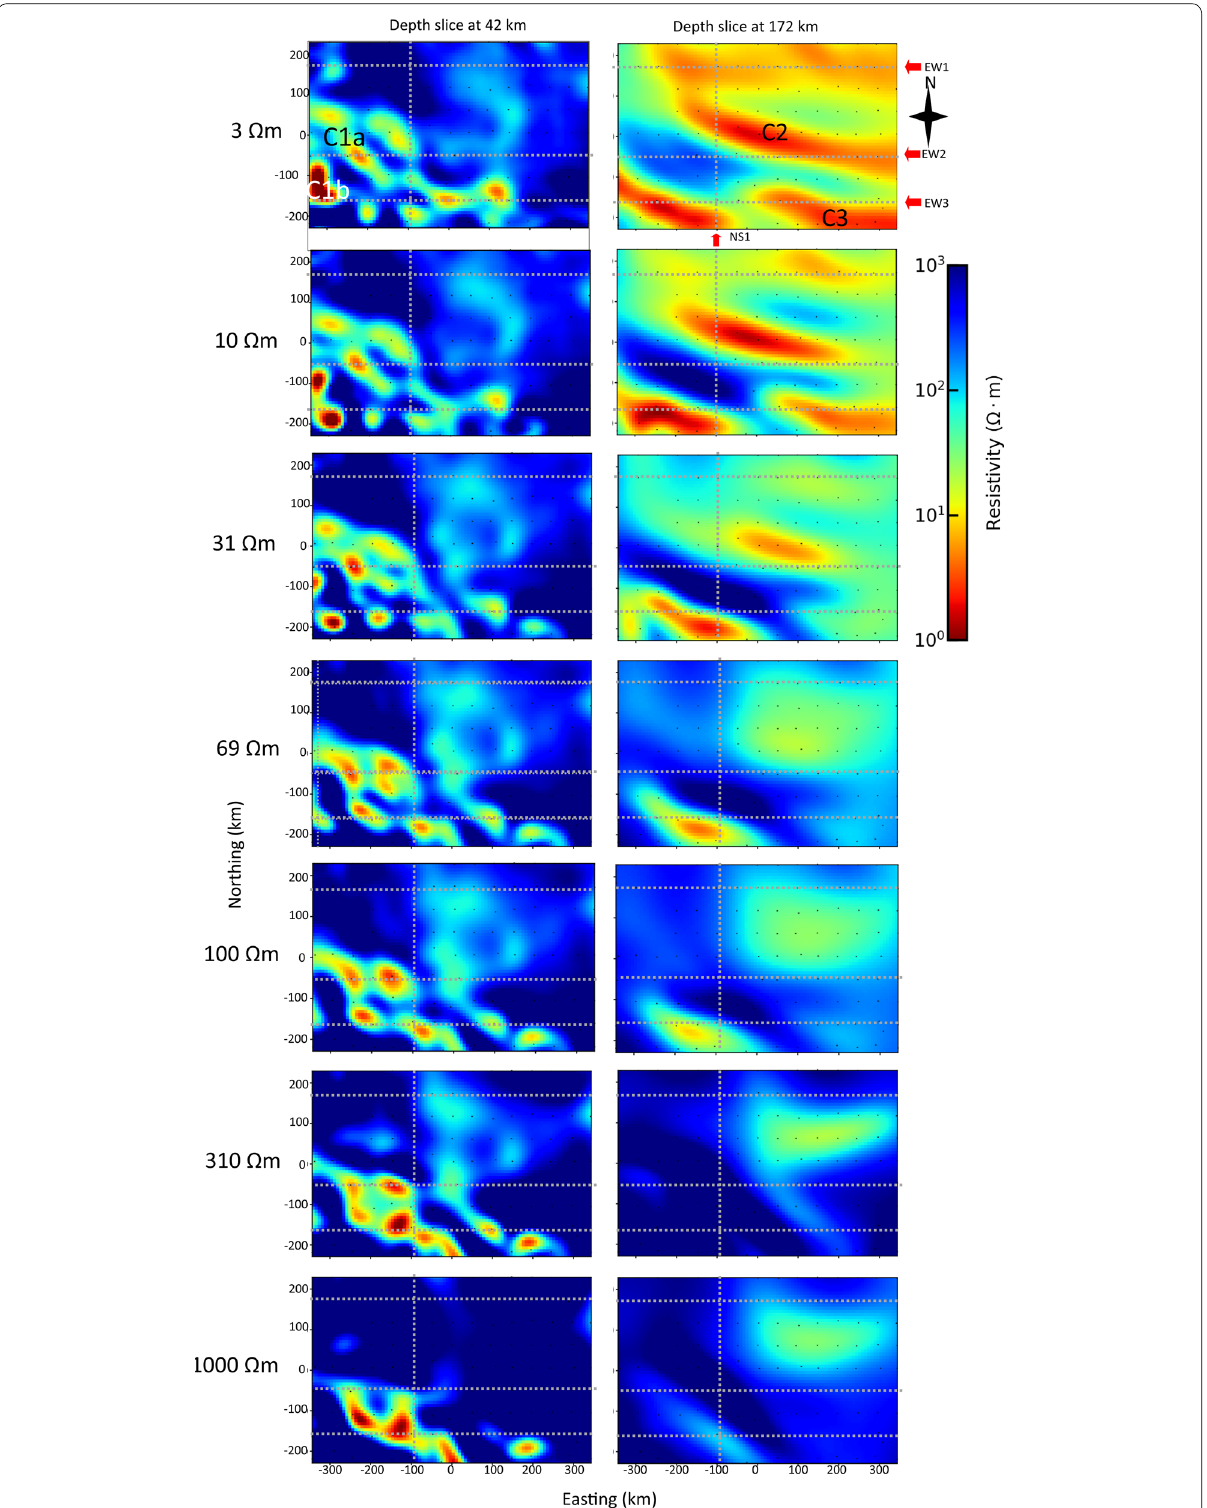
Fig. 9 Column 1: depth slice through inversions with 3, 10, 31, 69, 100, 312 and 1000 (cid:31) m prior resistivity at a depth of 42 km. Column 2: as column 1 but for a depth of 172 km. The location of the sections from Fig. 10 is shown as grey dashed lines on the right-hand